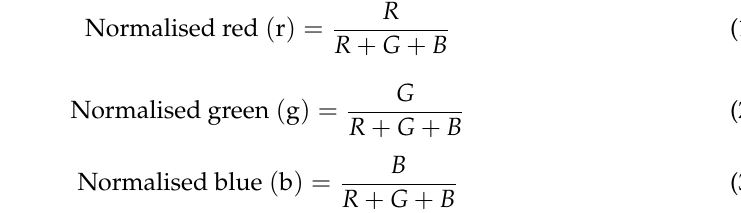
Table 2. Colour indices, formulas, and